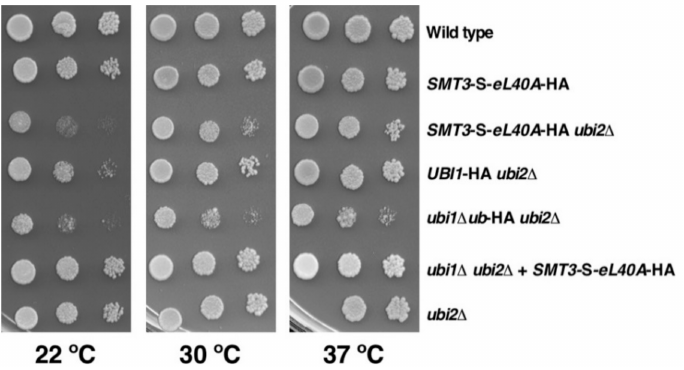
Figure 3. The genomically integrated SMT3-S-eL40A -HA allele permits better growth than the corresponding ubi1 ∆ ub -HA allele. Growth analysis of the indicated strains, either expressing a C-terminally HA-tagged Ubi1 ( UBI1 -HA) or a Smt3-S-eL40A ( SMT3-S-eL40A -HA) fusion variant protein from the UBI1 genomic locus or from a centromeric plasmid ( + SMT3-S-eL40A -HA) in a wild-type UBI2 or a ubi2 ∆ null mutant background. Strains W303-1A (Wild type), SMY218 ( SMT3 - S-eL40A -HA), SMY258 (SMT3- eL40A -HA ubi2 ∆ ), SMY256 ( UBI1 -HA ubi2 ∆ ), SMY257 ( ubi1 ∆ ub -HA ubi2 ∆ ), SMY216 [YCplac111-SMT3-S-eL40A-HA] ( ubi1 ∆ ubi2 ∆ + SMT3-S-eL40A-HA), and JDY923 ( ubi2 ∆ ) were spotted in fivefold serial dilution steps onto YPD plates, which were incubated for 4 days at 22 ◦ C and for 3 days at 30 ◦ C and 37 ◦